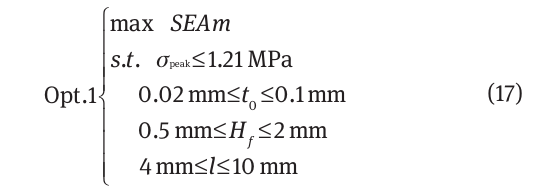
= 1.5 t = 0.09 mm). (C) R1 ( t 1 0